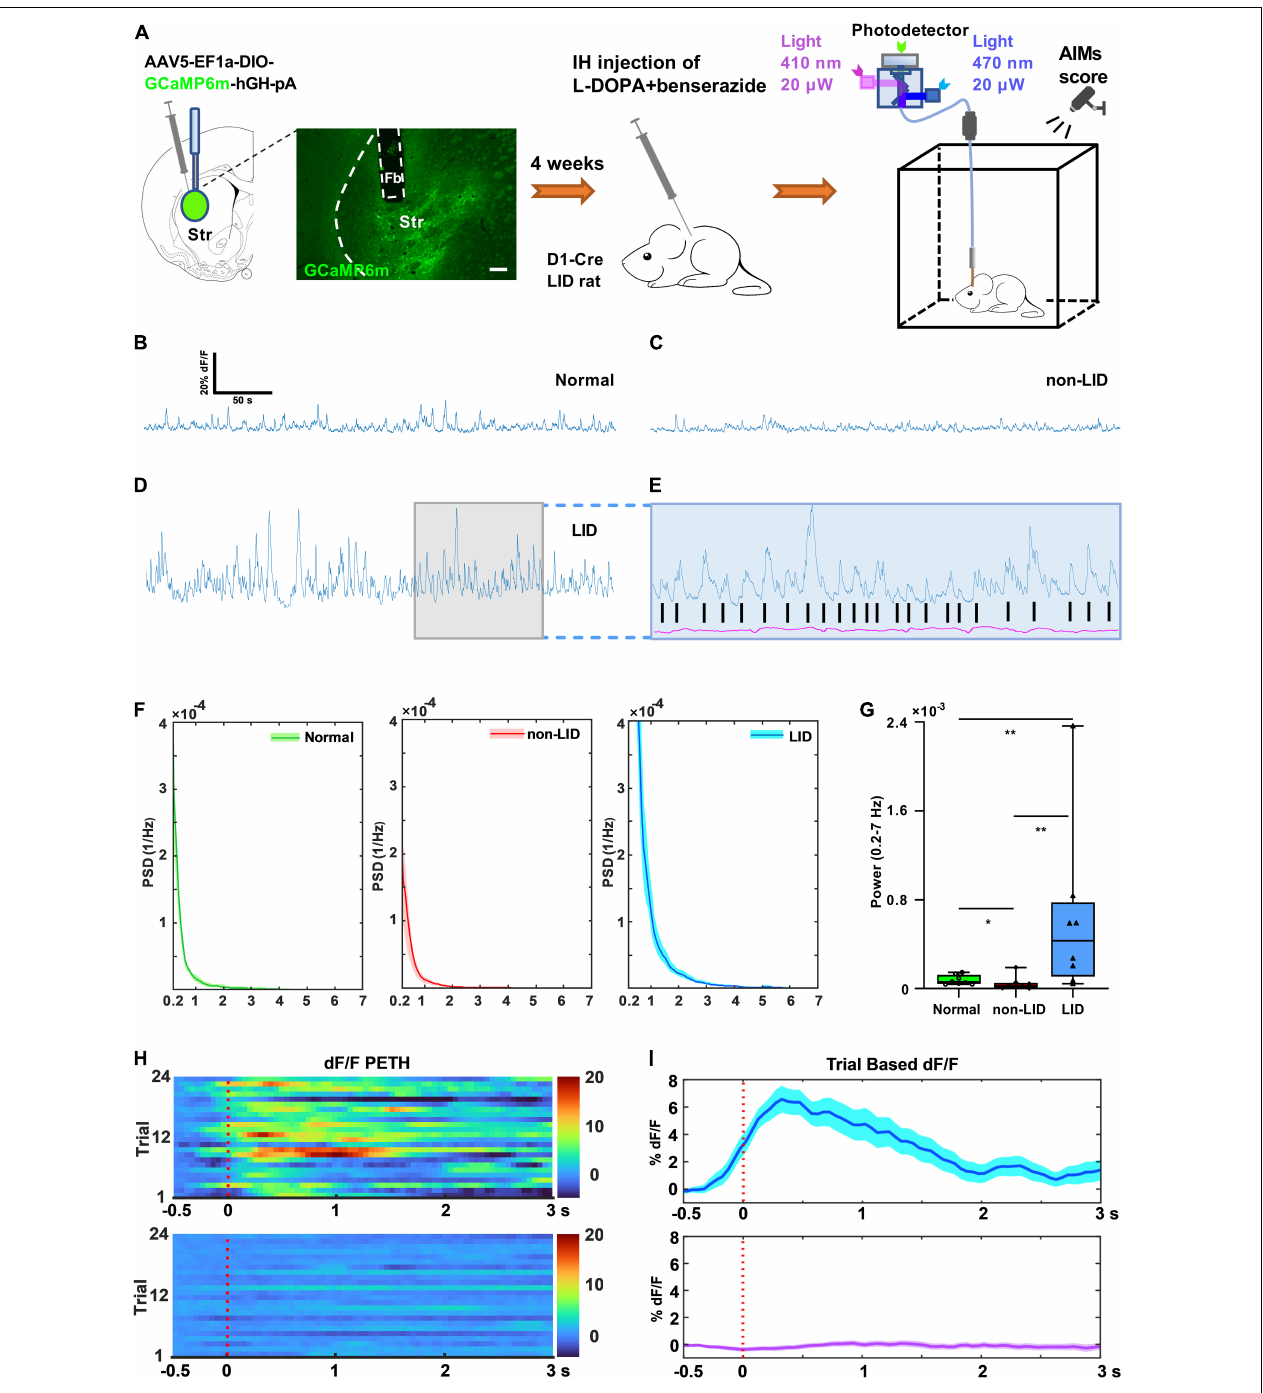
FIGURE 2 | Striatal D 1 + neuronal population activity during dyskinetic period in rats with levodopa-induced dyskinesia (LID). (A) Experimental setup for the GCaMP 6m -based fiber photometry assay (scale bar = 200 µ m). Representative striatal D 1 + GCaMP signal (dF/F, 300 s) of a normal control (B) , non-LID rat (C) , and LID rat (D) obtained at 30–80 min after levodopa injection. (E) Photometry traces from isosbestic control (410 nm, purple) and GCaMP (blue) of a LID rat showing robust increases in GCaMP fluorescence (dF/F), which correlated with the onsets of each dyskinetic movement (black vertical lines). (F) Power spectral density (PSD) plots of GCaMP fluorescence traces (300 s, dF/F) obtained from normal, non-LID, and LID rats (data are presented as mean ± standard error of the mean, n = 8 for each group). (G) Power (at 0.2–7 Hz over 5 min) obtained from GCaMP fluorescence traces (dF/F) of normal, non-LID and LID rats ( n = 8 for each group, Kruskal–Wallis one way analysis of variance on ranks with post-hoc Student–Newman–Keuls Method: H 2 = 12.560, P = 0.002; LID vs. non-LID: q = 5.000; LID vs. normal: q = 4.159; Normal vs. non-LID: q = 3.267; * P < 0.05, ** P < 0.01). Representative heatmaps (H) and peri-event time histograms (PETH, I ) aligned to the start of each dyskinetic movement for GCaMP (top) or isosbestic control (bottom) traces. SC, subcutaneous.